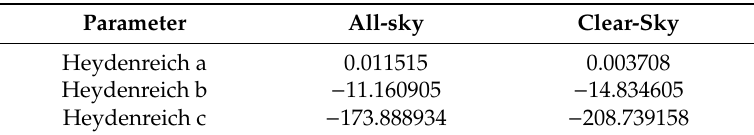
Table 3. Optimized parameters for Heydenreich et al. model considering all-sky and clear-sky